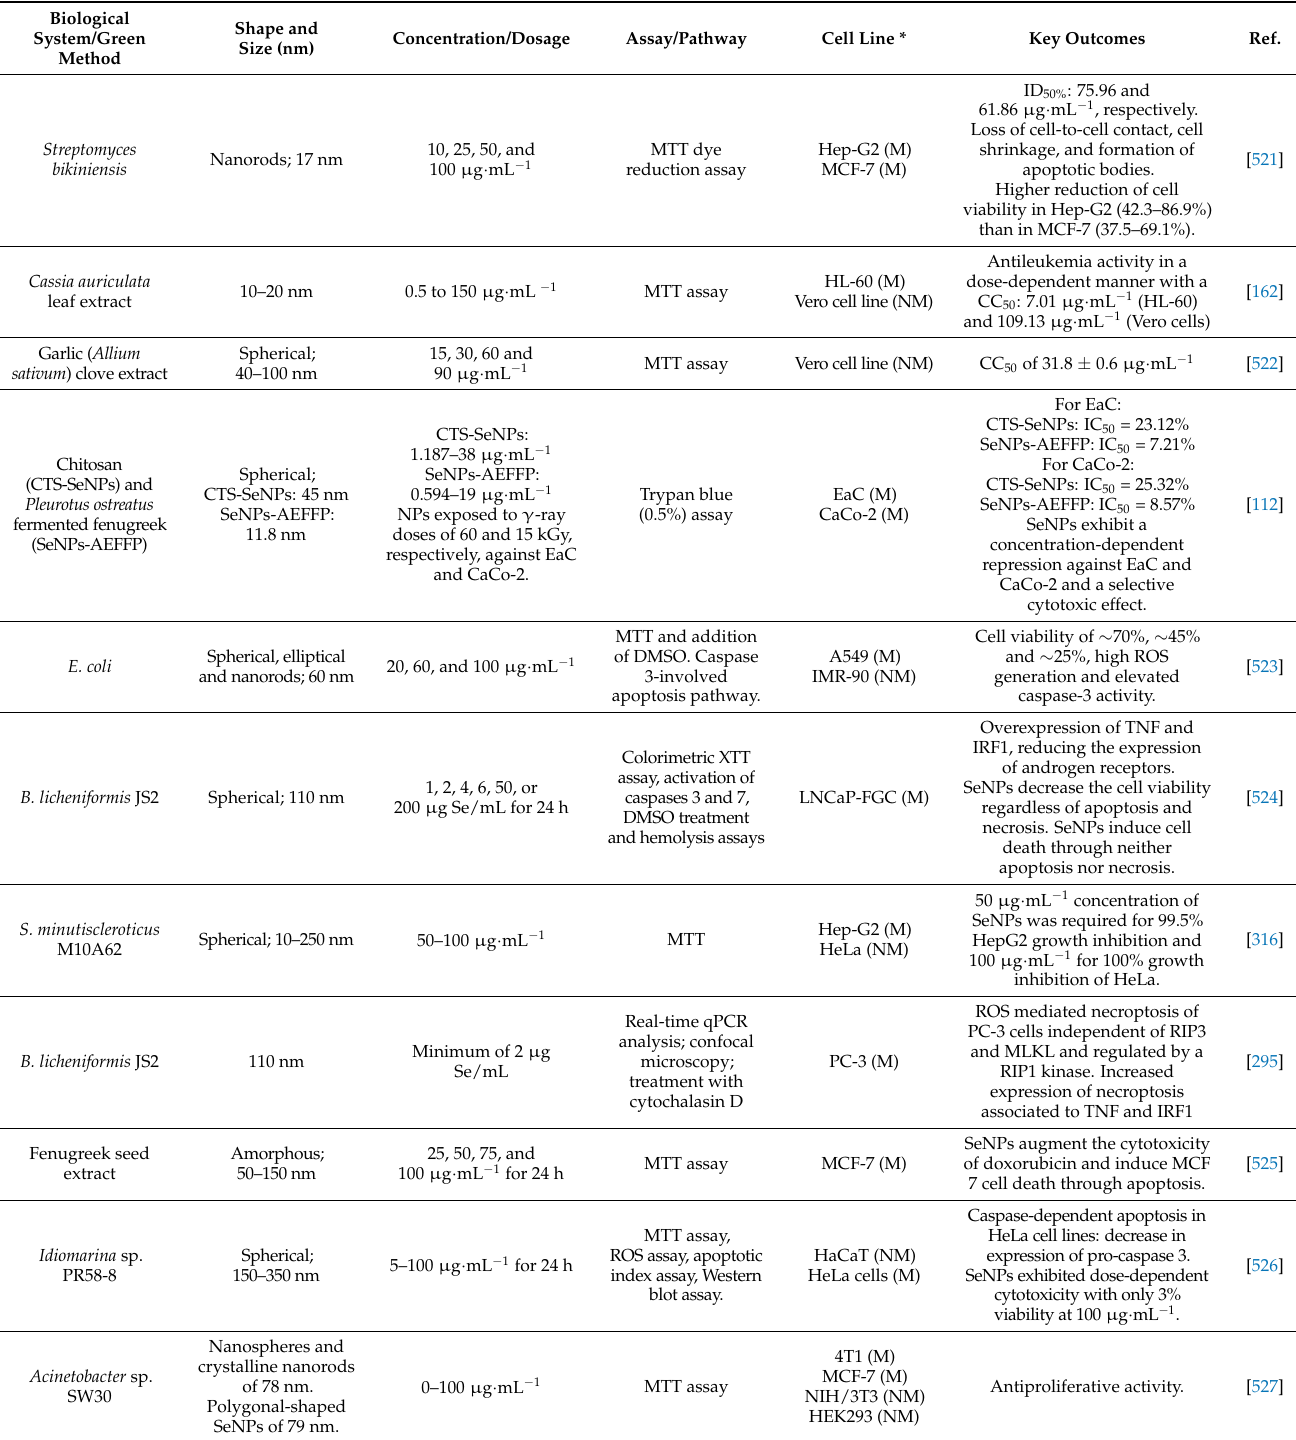
Table 4. Anticancer activity of several biogenic SeNPs against different cancer cell